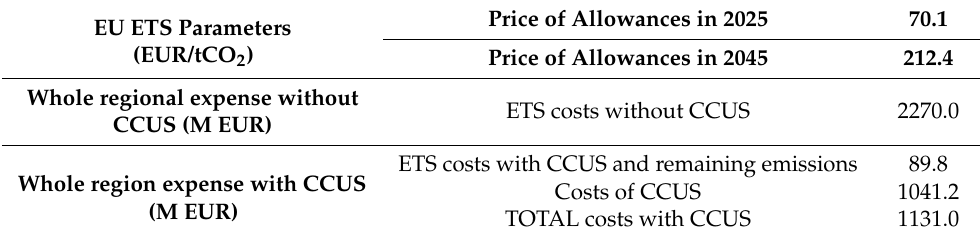
Table 5. Analysis of EU ETS allowance in the scenario and energy consumption.